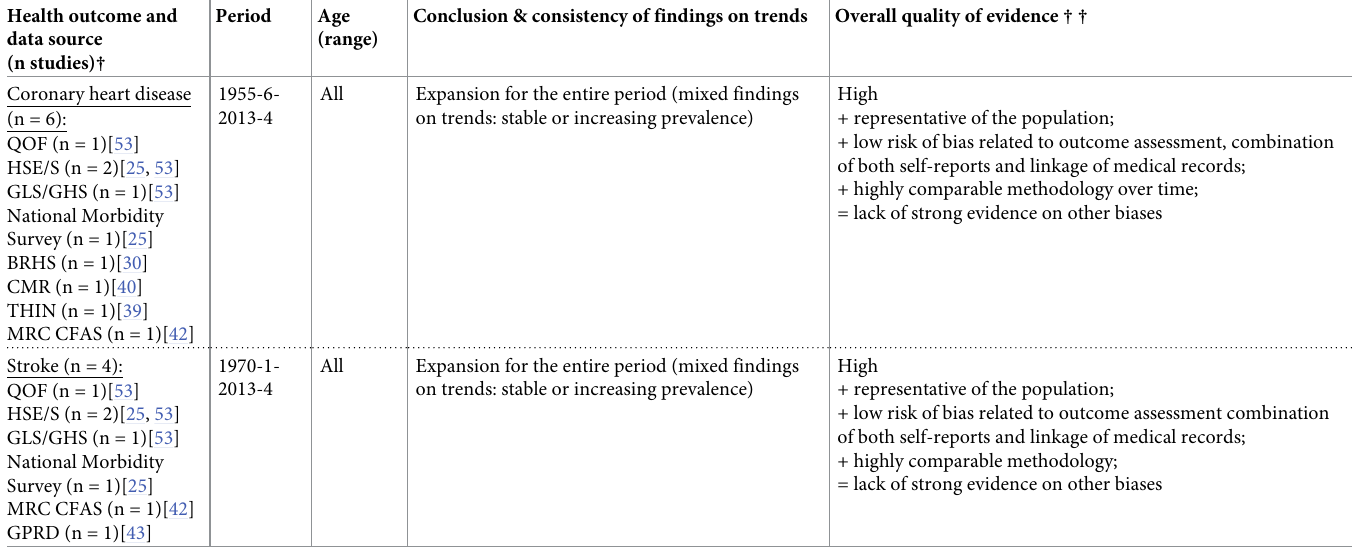
Table 3. The characteristics of evidence on prevalence of each health outcome, with the emphasis on size, consistency and quality. Health outcome and data